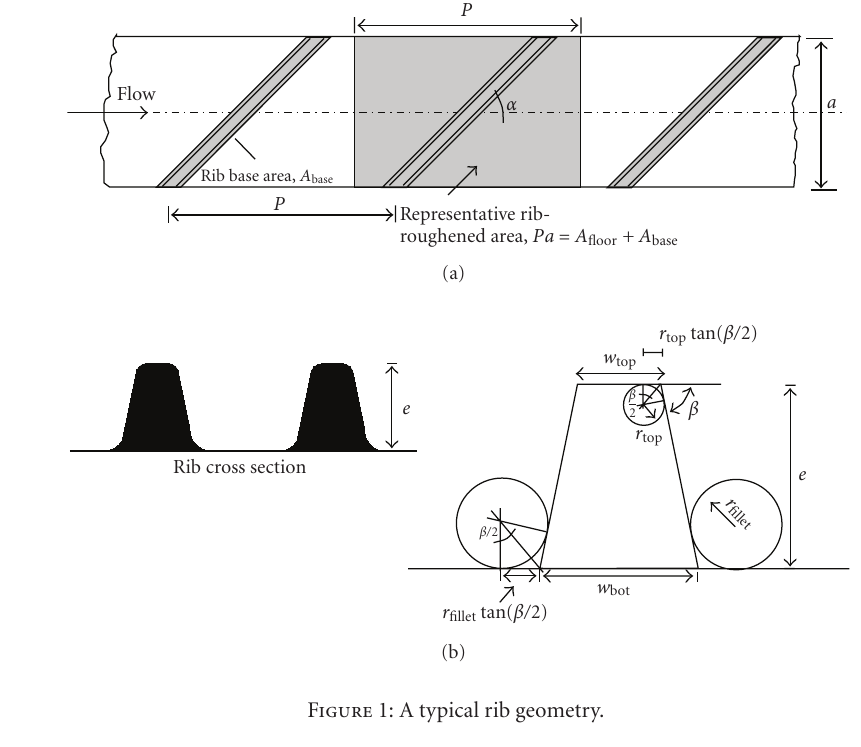
Figure 1: A typical rib geometry.